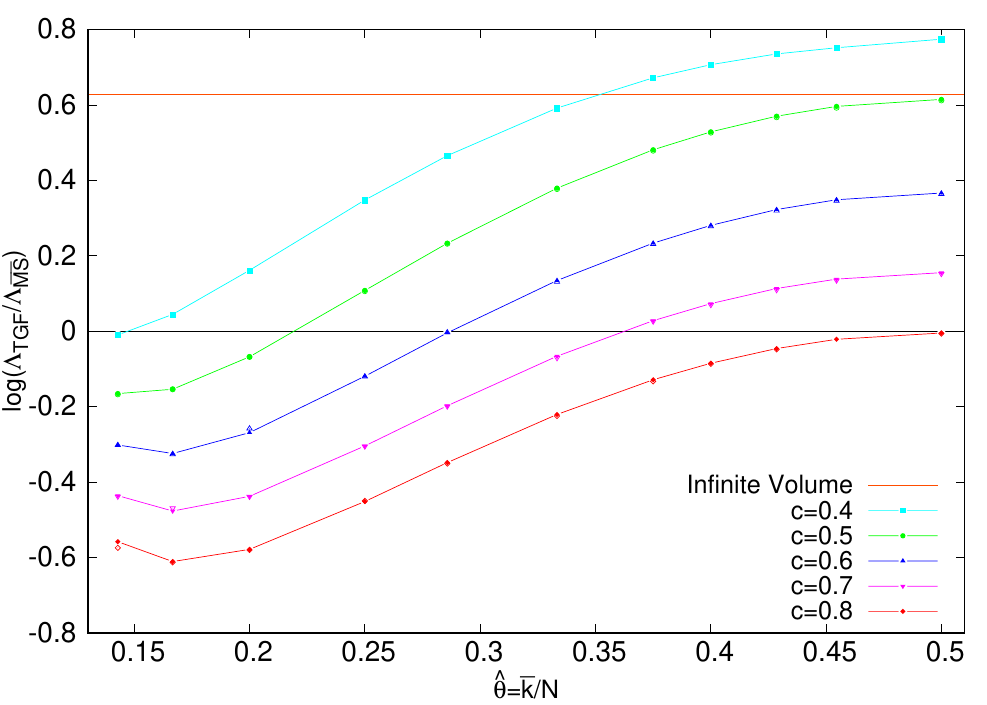
Figure 2. We display log((cid:3) TGF = (cid:3) ) as a function of ^ (cid:18) = (cid:22) k=N for di(cid:11)erent choices of gauge group MS and magnetic (cid:13)ux. The hollow and full symbols correspond to the results of the Mathematica and C++ codes respectively, though the overlap makes them indistinguishable in almost every case. The error bars of the results are smaller than the symbols used, but the errors can easily be worked out from table